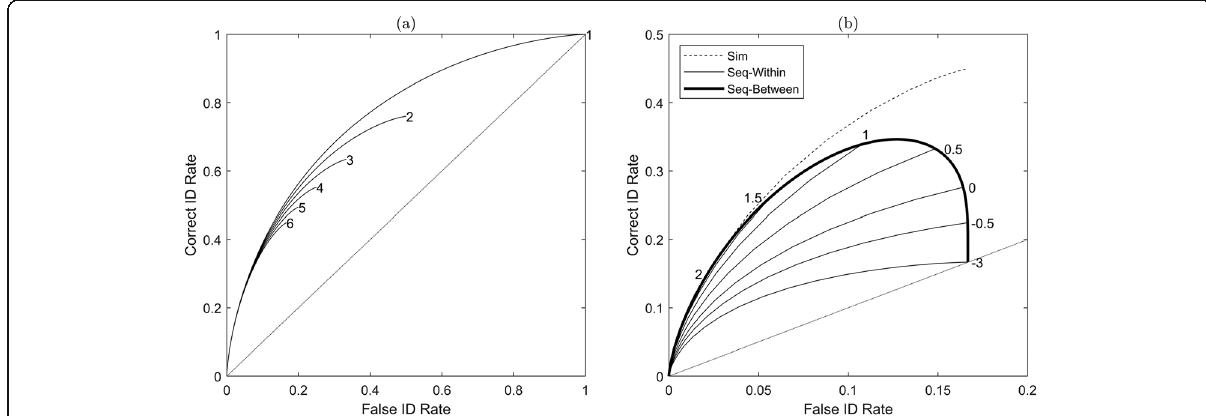
Fig. 2 The effect of task characteristics on the shapes of ROC curves. a The set of ROC curves for simultaneous lineups of sizes 1 (show up) to 6 as indicated on the figure. Each curve is associated with the same underlying d t = 1. b The set of ROC curves for simultaneous and sequential lineups of size 6 and d t = 1. The dashed line is the ROC curve for a simultaneous lineup, identical to curve 6 in panel a . The thin solid lines are the ROC curves for a sequential lineup associated with different minimum criteria to choose, ranging from conservative (2) to lenient ( − 3). The thick solid line is the ROC curve for a sequential lineup in which response bias is manipulated between participants and ranges from most conservative to most